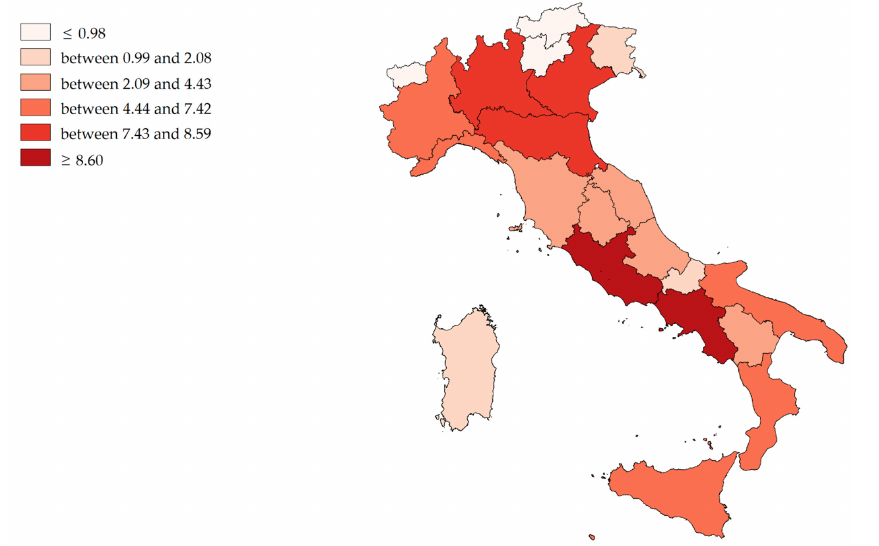
Figure 5. Cartographic representation of Escape Production Indexes (EPI) for hospital orthopedic intensive rehabilitation, mean from 2011 to 2019.